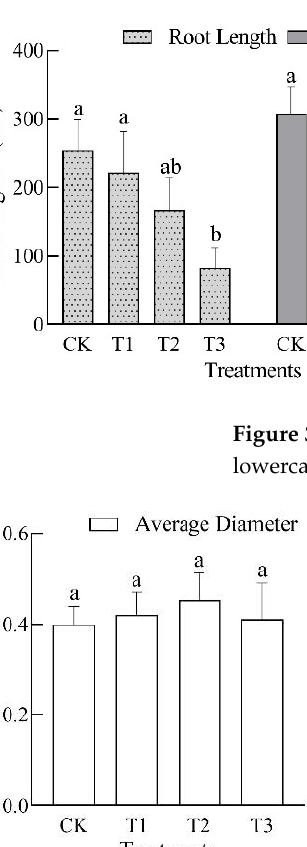
Figure 4. Effects of different treatments on the root average diameter, and numbers of root tips, forks, and crosses. Note: Different lowercase letters indicate that the differences between treatments reached a significant level ( p <